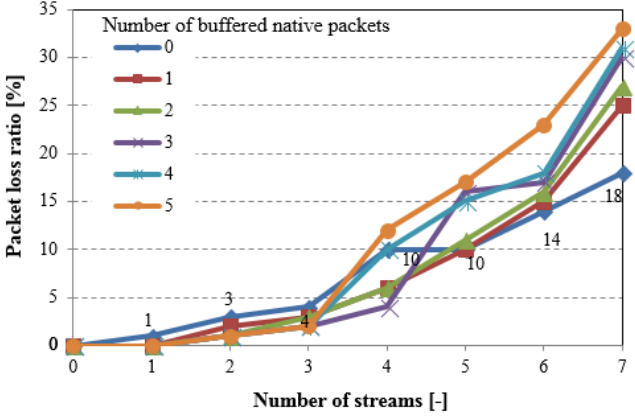
Figure 12. Packet lose ratio (extended testing scenario).